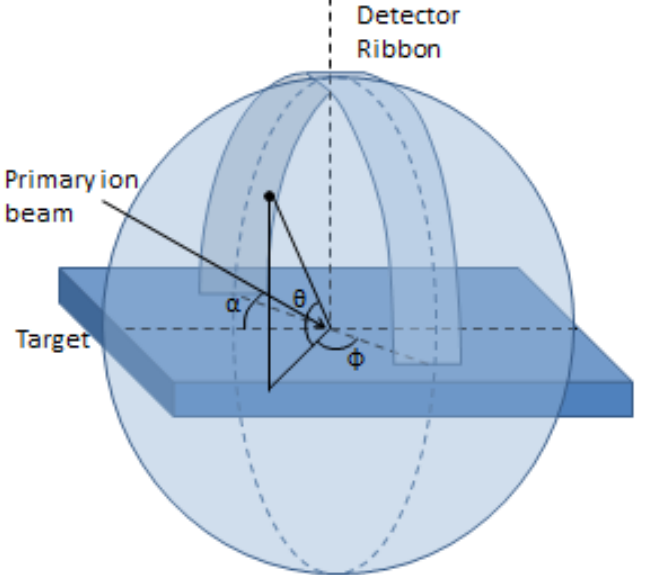
Figure 7. Geometry of the sputtered ion ribbon detector after references [21,22]. Ions impacting the detector ribbon are counted with identification of the detection angle ( θ ): θ is the polar angle between the target surface and the vector from the ribbon detector center to the detection point on the ribbon, α is the incidence angle of the primary ion beam with respect to the target surface, and ϕ is the azimuthal angle in the target plane.